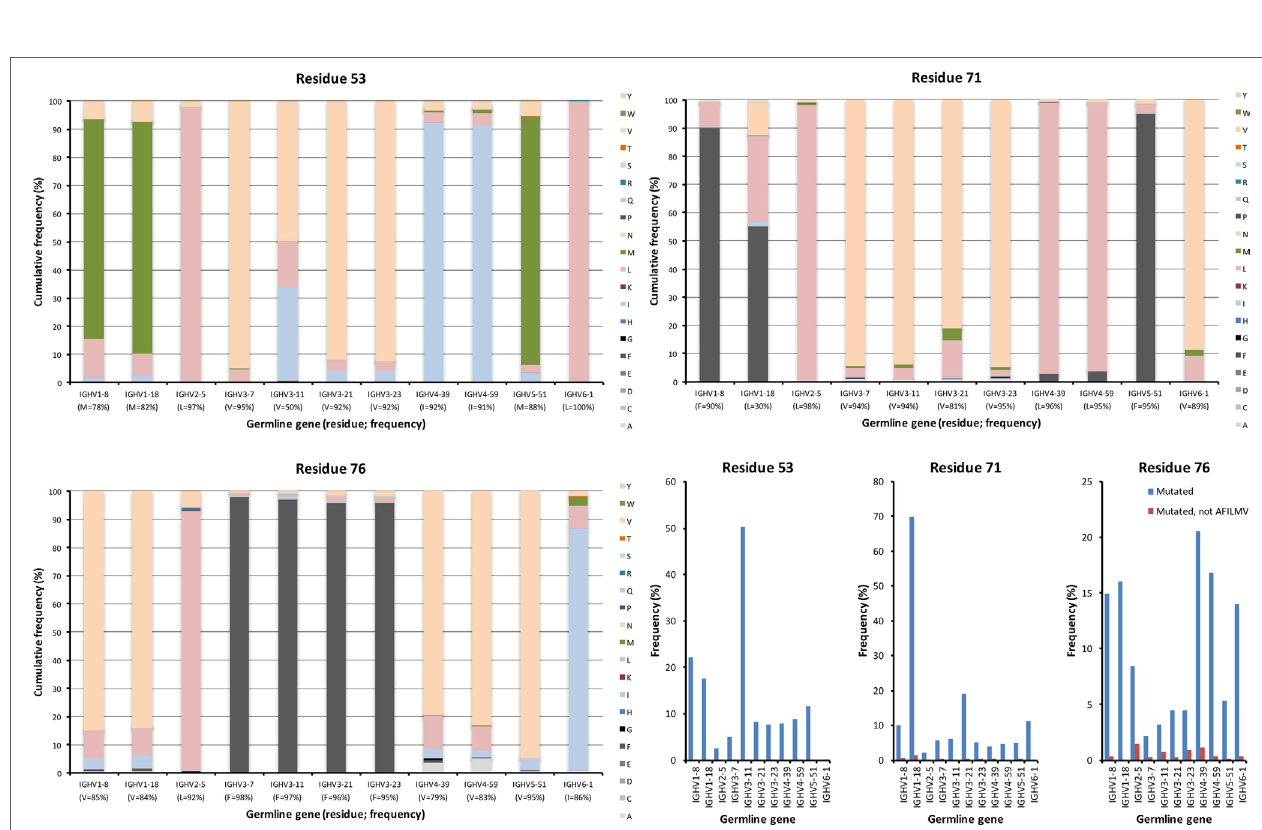
FigUre 7 | Substitutions of lower core residues 53, 71, and 76 as introduced during somatic hypermutation processes of IgG-encoding genes derived from different germline genes. The diversification of these mostly hydrophobic residues largely results in introduction of other hydrophobic residues (panels to the bottom